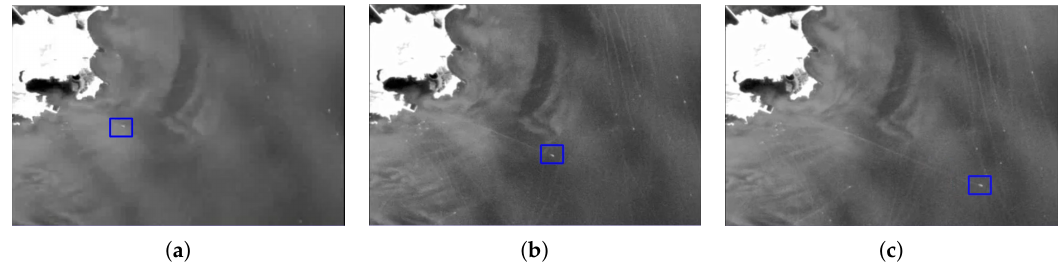
Figure 13. From left to right are the ( a ) second frame, ( b ) fifth frame, and ( c ) 11th frame of the image sequence,